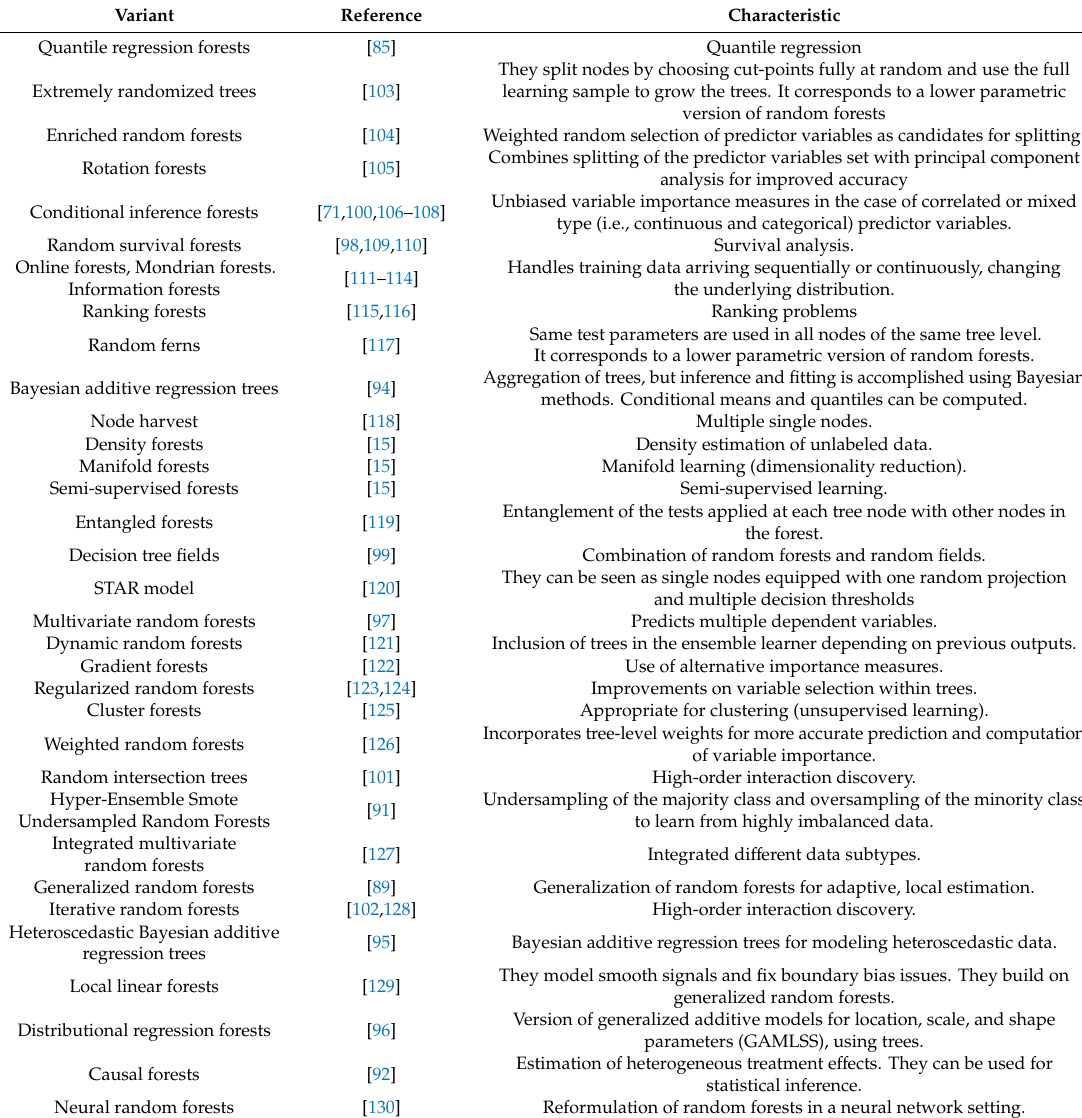
Table 2. Variants of random